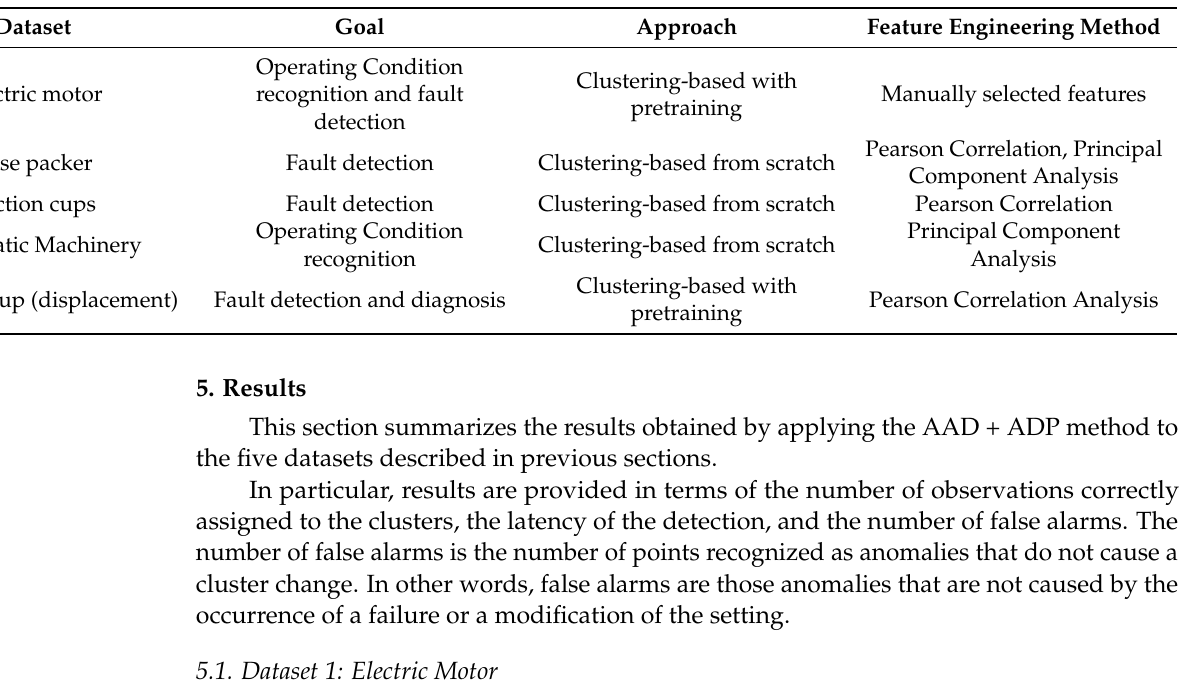
Table 2. Description of each case study’s goals, approaches, and feature extraction